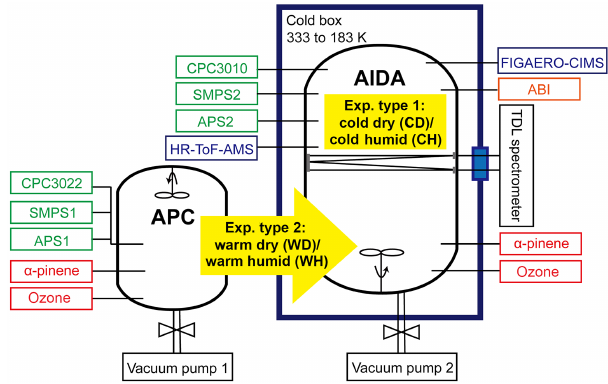
Figure 1. Simple schematic and conditions for the two types of ex- periments (modified from Wagner et al., 2017). Both chambers at IMK (APC and AIDA) were used in this study. Instruments are an- notated in green, blue, and orange, and precursor gases in red. More detailed information on the instruments and precursor gases are ex- plained in the